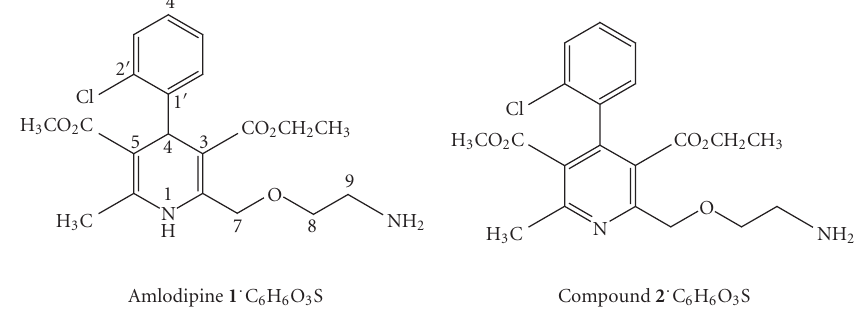
Scheme 1: Structures of drug and its photoproduct.